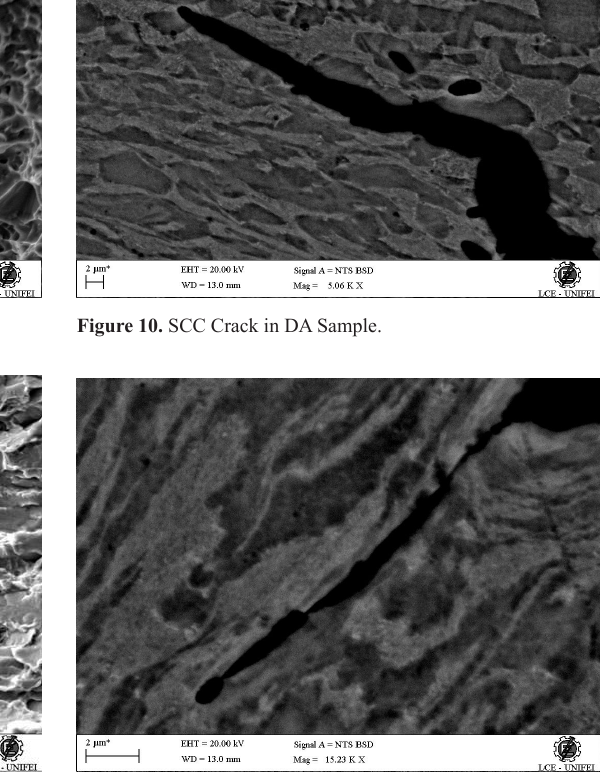
Figure 11. SCC Crack in SA